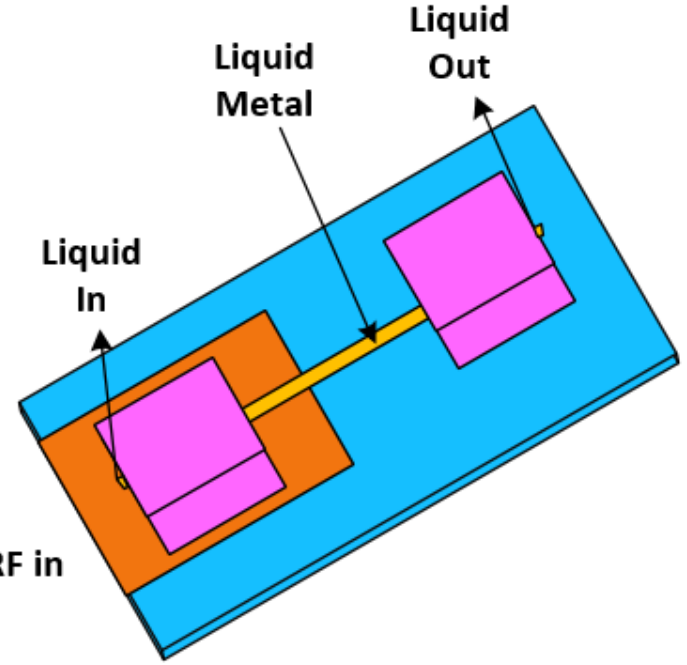
Figure 13. Liquid metal monopole.